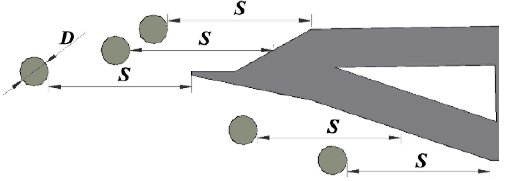
Figure 5. ( a – n ) The detailed geometry of the body-height grids I–XIV, respectively (unit: mm).